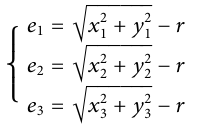
coordinate axis dot o, a plane coordinate system is established. The x -axis and the geographical North direction is taken as the positive